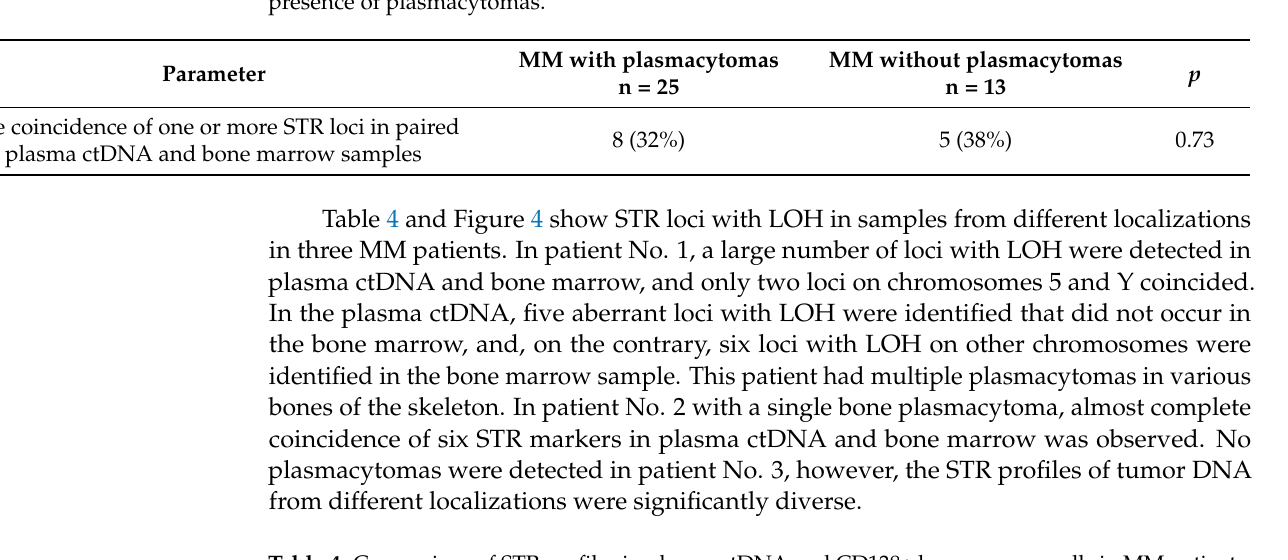
Table 4. Comparison of STR profiles in plasma ctDNA and CD138+ bone marrow cells in MM patients. Patient Number